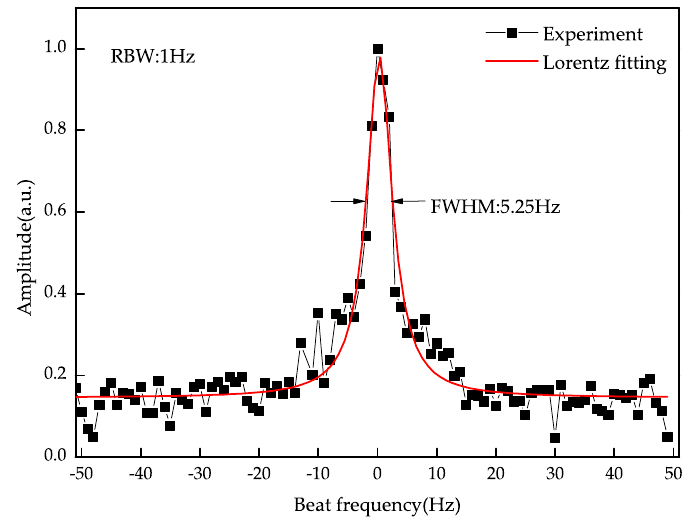
Figure 10. Beat linewidth